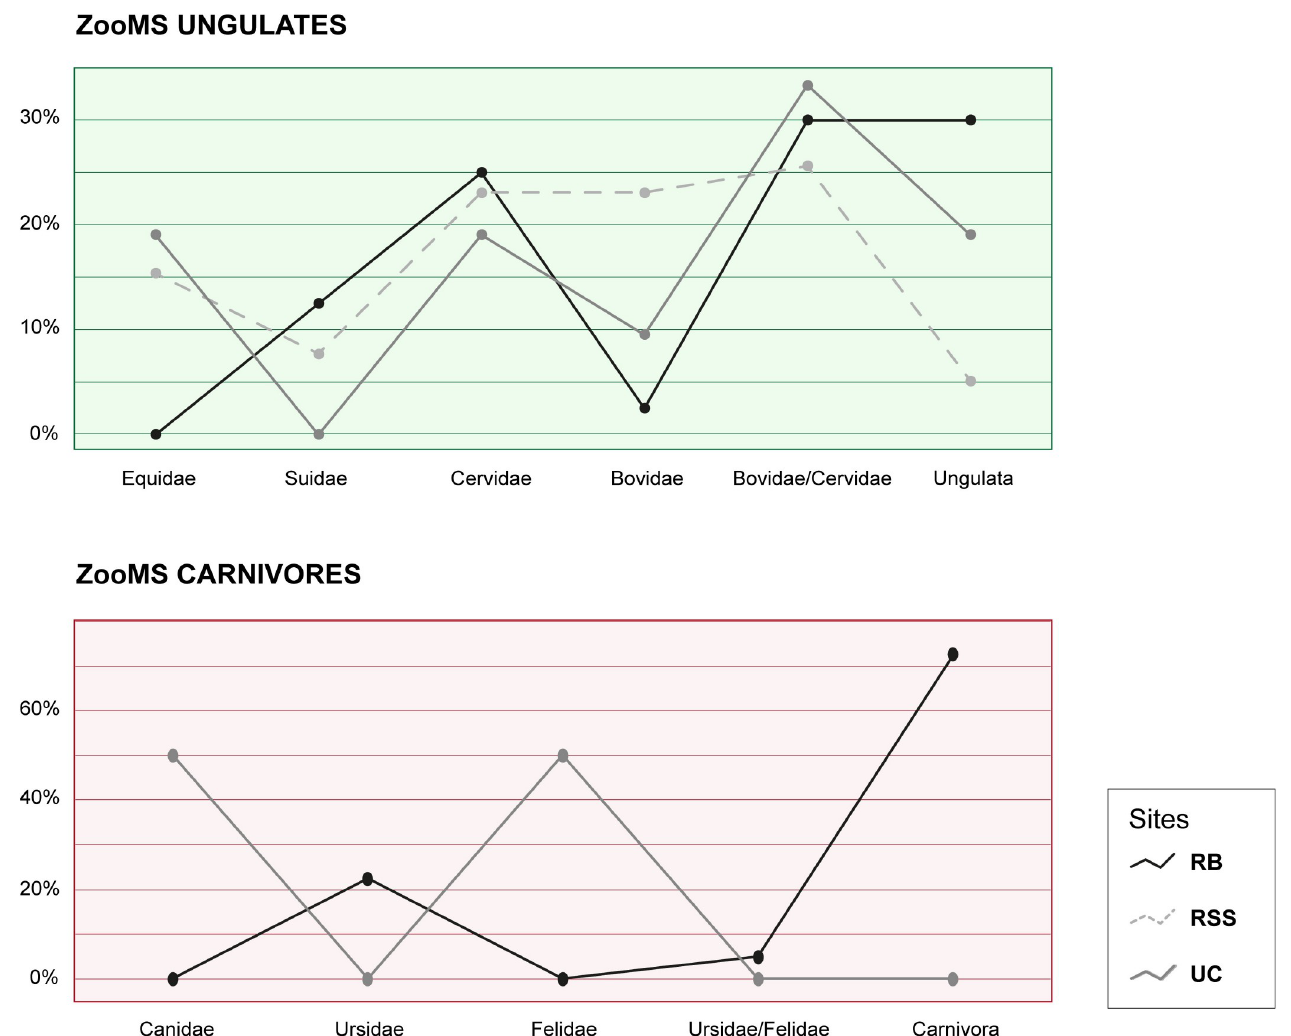
Fig 4. Percentages of Ungulates and Carnivores obtained by ZooMS for RB (Riparo del Broion), RSS (Roccia San Sebastiano cave) and UC (Uluzzo C Rock